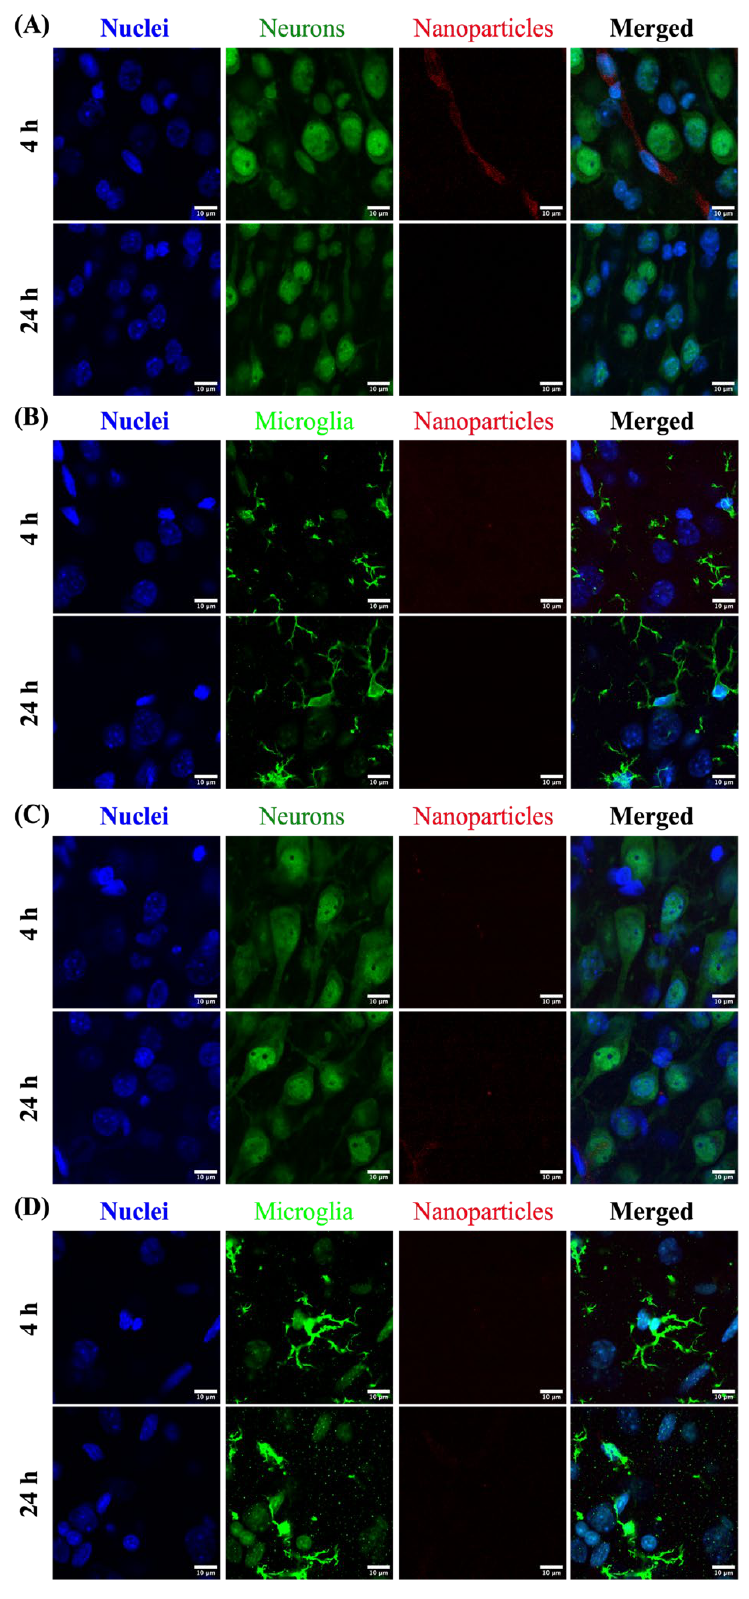
Figure 6. Localizations of PLGA-PEG/F127 and PLGA-PEG/P80 nanoparticles (red) in the cortex of healthy P10 rat brain at 4 h and 24 h after administration. ( A ) PLGA-PEG/F127 in cortical neurons, ( B ) PLGA-PEG/F127 in cortical microglia, ( C ) PLGA-PEG/P80 in cortical neurons, and ( D ) PLGA-PEG/P80 in cortical microglia. Blue: DAPI nuclei stain. Scale bars: 10 µ